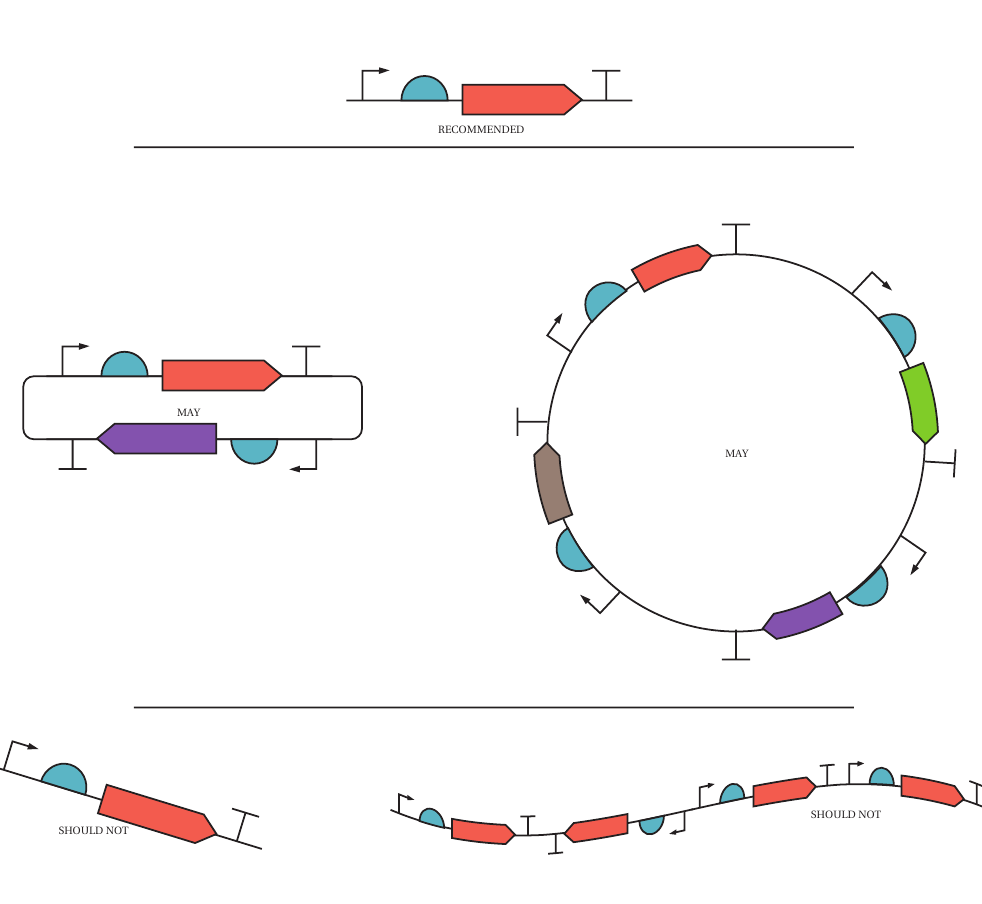
Figure 7: Recommended, acceptable, and problematic examples of nucleic backbone orientation.